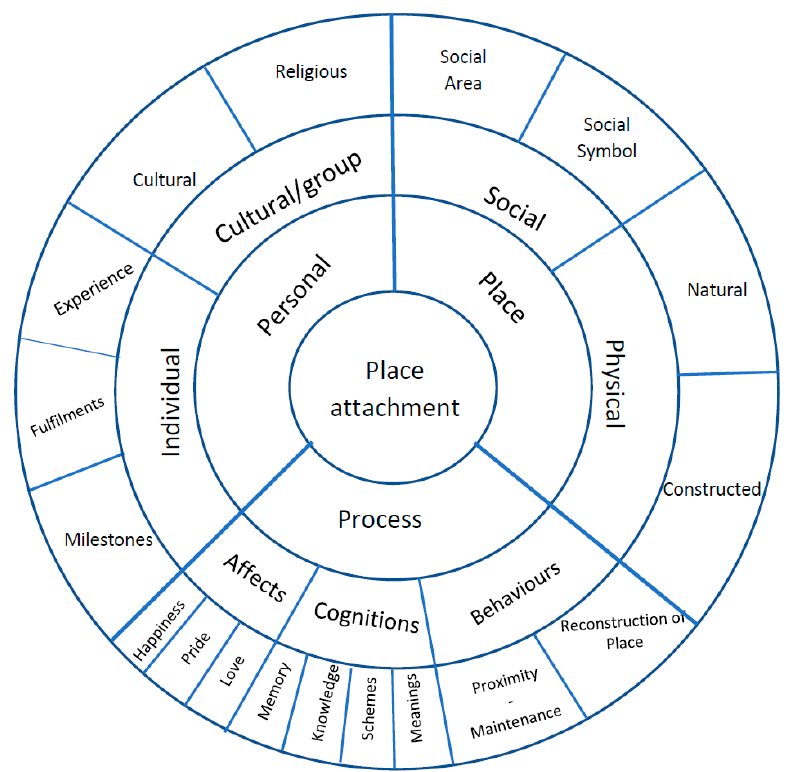
Figure 1. Three-dimensional model of place attachment. Source: [18].